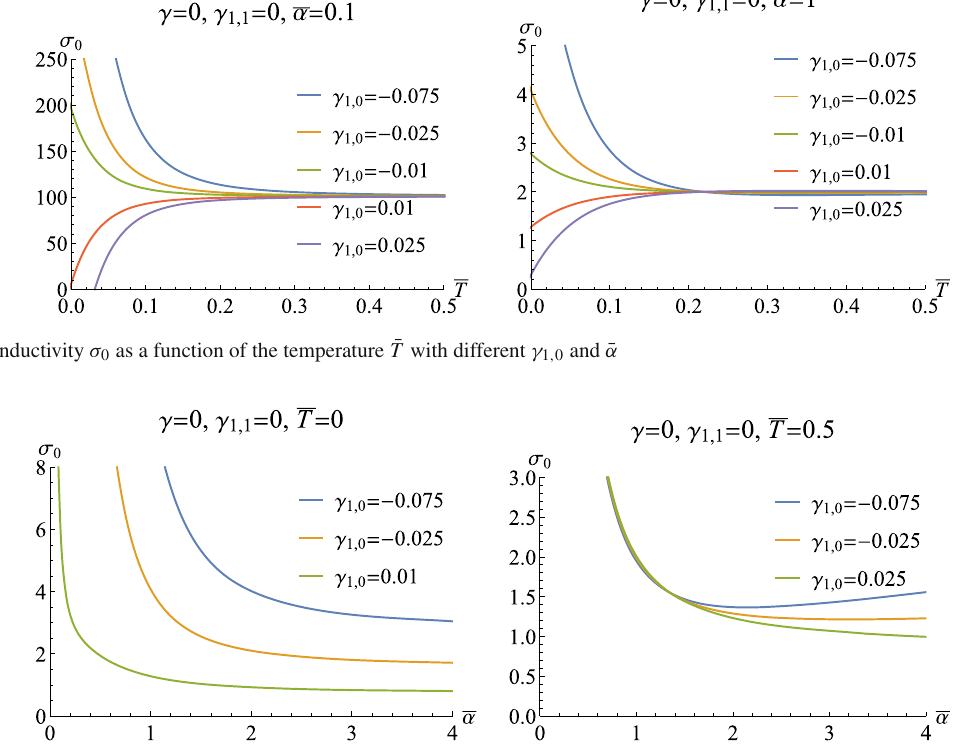
Fig. 2 DC conductivity σ 0 as a function of ¯ α with different γ 1 , 0 at zero temperature (left plot) and finite temperature (right plot), respectively